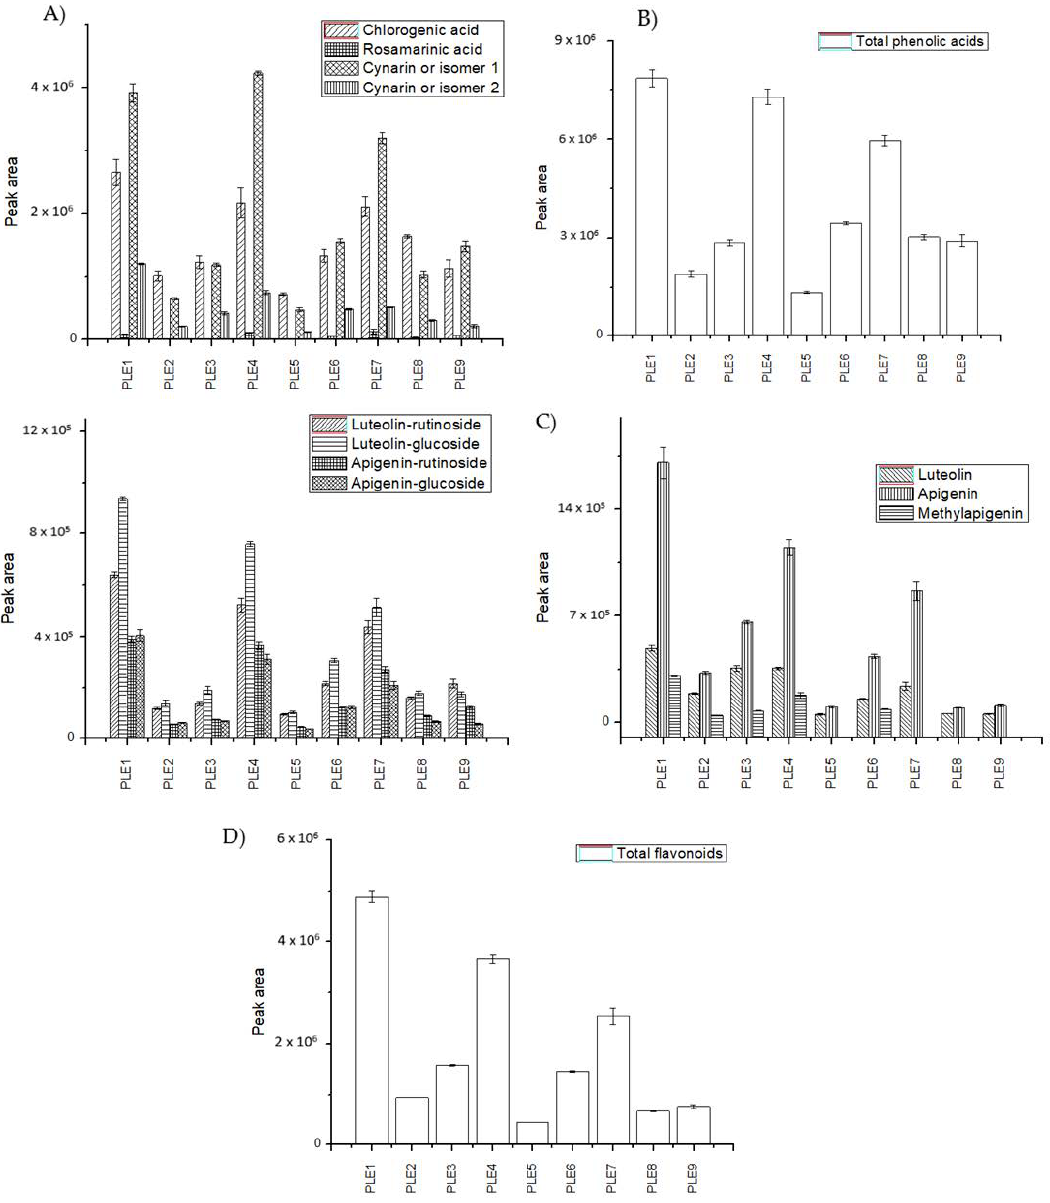
Figure 3. Abundance of phenolic compounds characterized in each C. scolymus PLE extracts by HPLC-ESI-TOF-MS: ( A ) individual phenolic acids, ( B ) total phenolic acids, ( C ) individual flavonoids, and ( D ) total flavonoids.